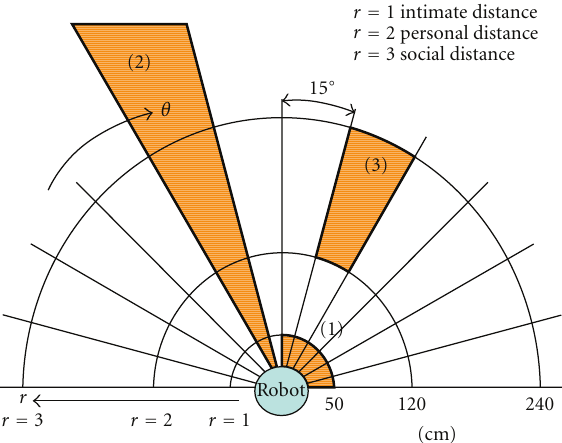
Figure 2: Friendliness space map and e ff ective area of